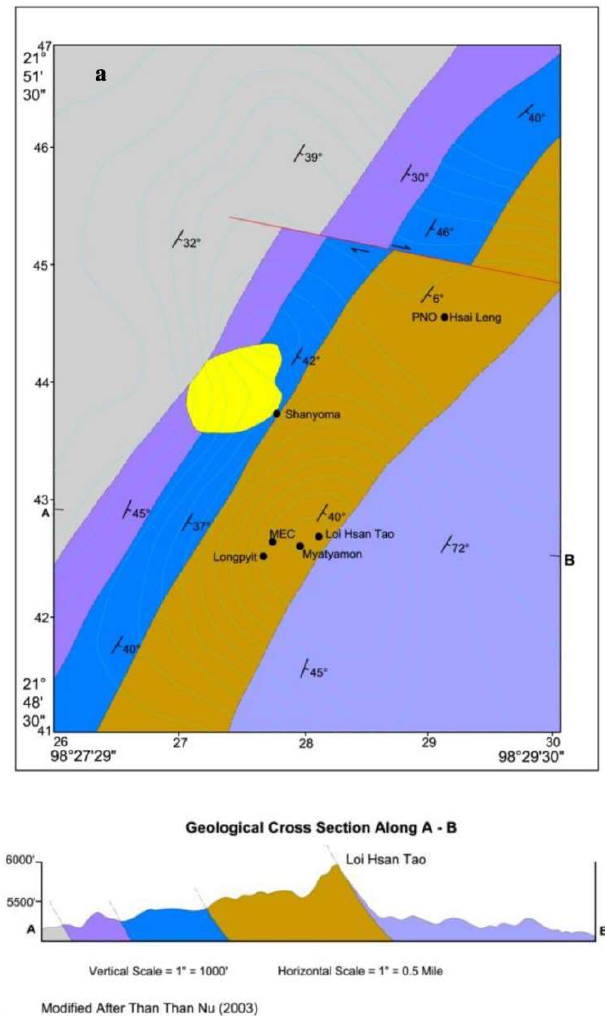
Figure 4. Geological map ( a ) and geological section ( A – B ) of Loi Hsan Tao Mountain, Mong Hsu area, Shan State, Myanmar, based on Than Than Nu in [36]. The ESE—dipping Lower Paleozoic fold belt sequence, younging from west to east includes Biotite Schist (grey), Calc-Silicates (purple), Dolomitic marble (brown), Phyllite and Quartzite (mauve). Alluvium (yellow) unconformably overlies the sequence. Structural features include strike directions (longer lines) with amount of dip (short lines normal to strike) and major fault (red line). The map north length represents 33.3 km. The ruby workings are indicated at around Lo Hasen Tao Mountain on map at cross section A–B, H/V = 2.64).